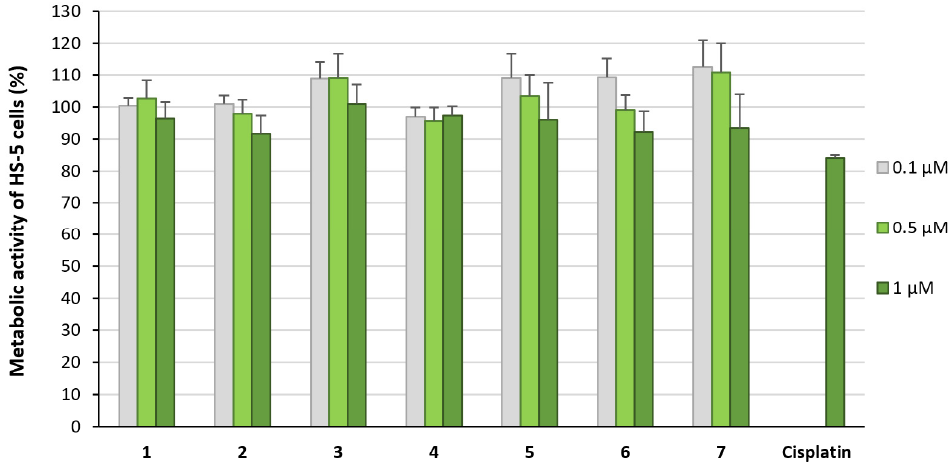
Figure 3. Metabolic activity of HS-5 cells treated for 72 h with complexes 1 – 7 at concentrations of 0.1 µ M to 1 µ M. Metabolic activity in the absence of the compounds was set at 100%. Data are expressed as mean + SE of eight experiments.